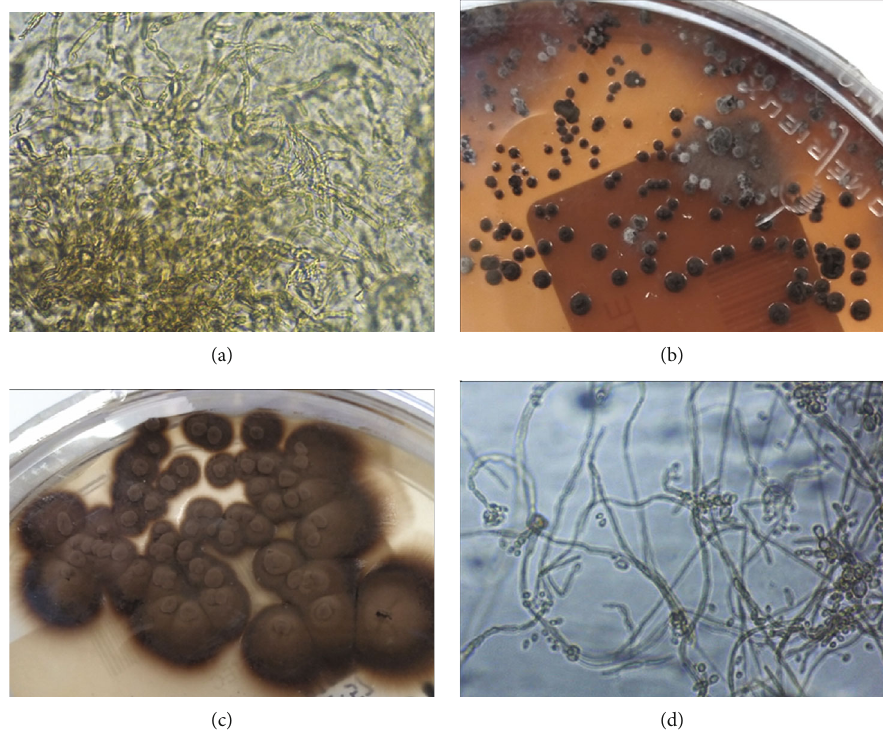
Figure 3: Microbiological examination. (a) Direct microscopy of ocular exudate: pigmented septate hyphae with some yeast cells. (b) Primary culture in blood agar medium and incubated at 37 ° C: black yeast colonies. (c) Primary culture in Sabouraud agar medium and incubated at 25 ° C: pigmented fi lamentous colonies. (d) Microscopic examination of the